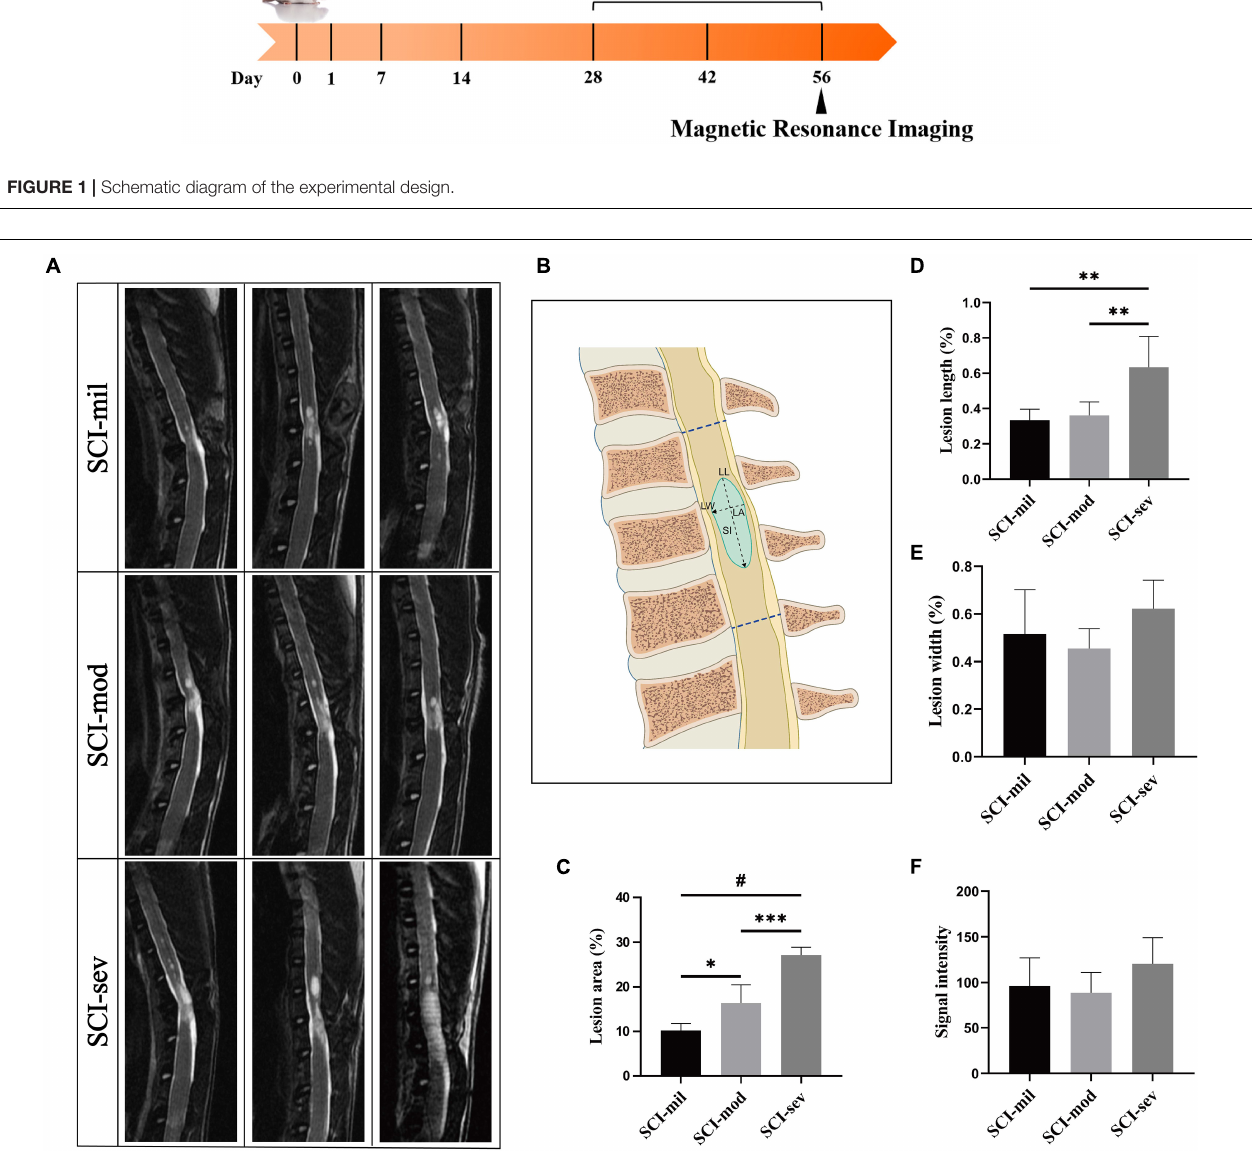
FIGURE 2 | MRI acquisition and analysis of lesion region. (A) Sagittal T2-weighted images of rats in three groups. (B) Schematic drawing of the parameters, which include lesion area (LA), lesion length (LL), lesion width (LW), and signal intensity (SI). LA was calculated as hyperintense region/overall region of T9–T11 vertebral canal × 100%. (C–F) Comparison among three groups on LA, LL, LW, and SI, respectively. n = 5 per group ( ∗ p < 0.05; ∗∗ p < 0.01; ∗∗∗ p < 0.001; # p <